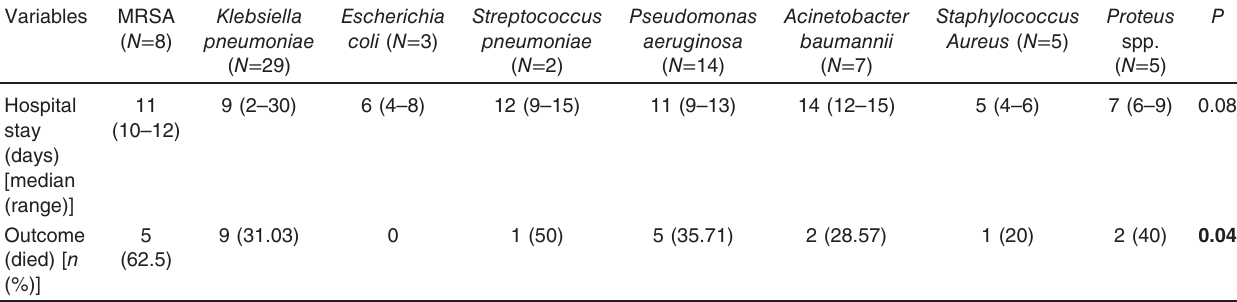
Table 5 Duration of hospital stay and outcome among studied patients